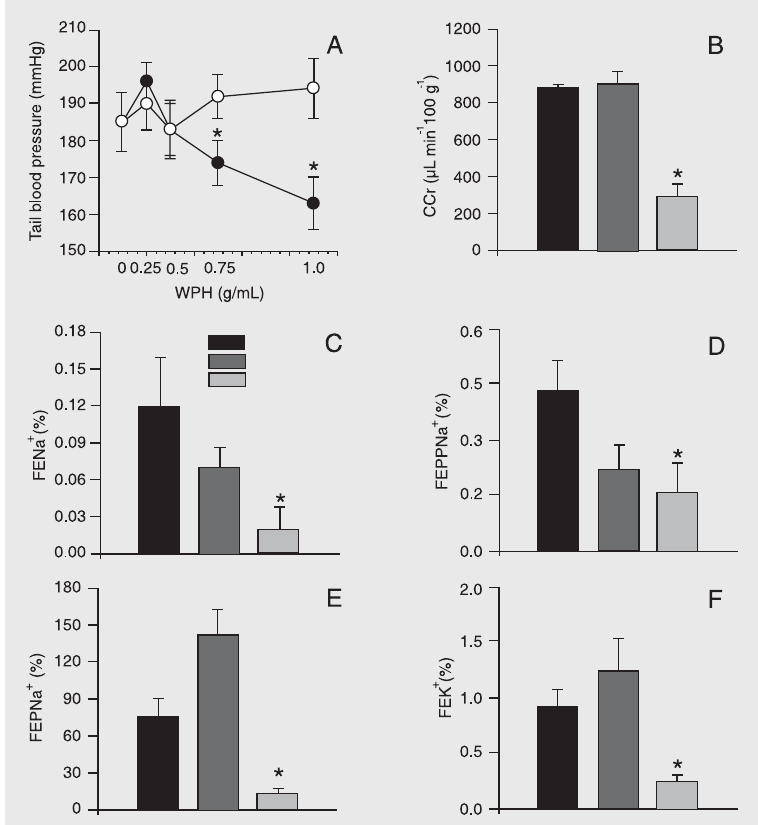
Figure 2. Effect of intraperitoneal administration of whey protein hydrolysate (WPH; 1.0 g/kg body weight) on arterial blood pressure (vehicle: open circles; WPH: closed circles, A), creatinine clearance (CCr, B), fractional excretion of sodium (FENa + , C), post-proximal (FEPPNa + , D), and proximal (FEPNa + , E) fractional excretion of sodium, and fractional excretion of potassium (FEK + , F). *P < 0.05 vs control (vehicle) group (Student t